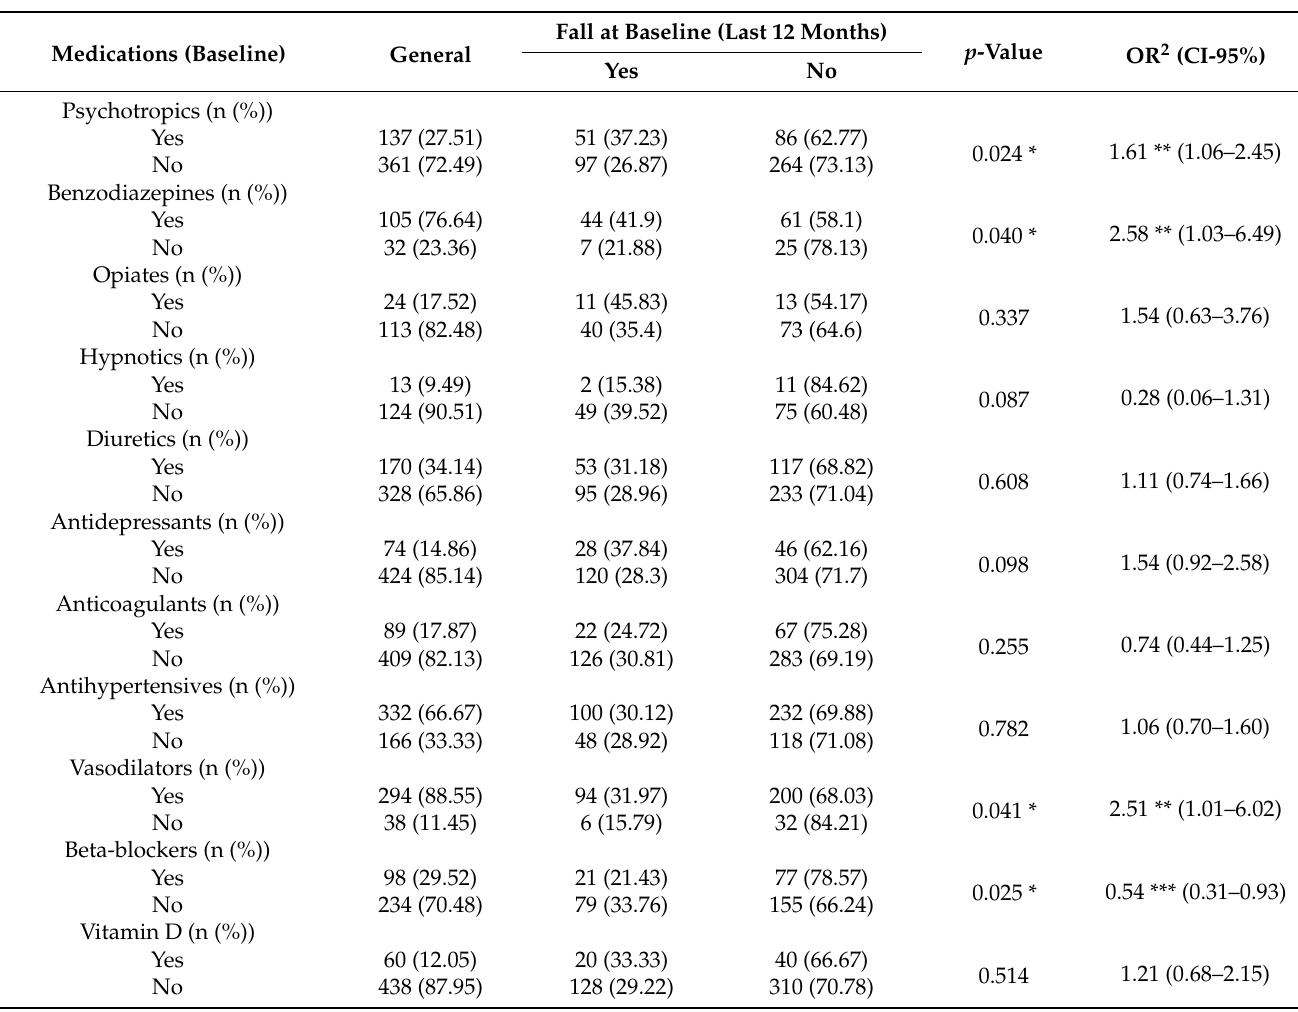
Table 2. Relationship between falls at baseline and medications.